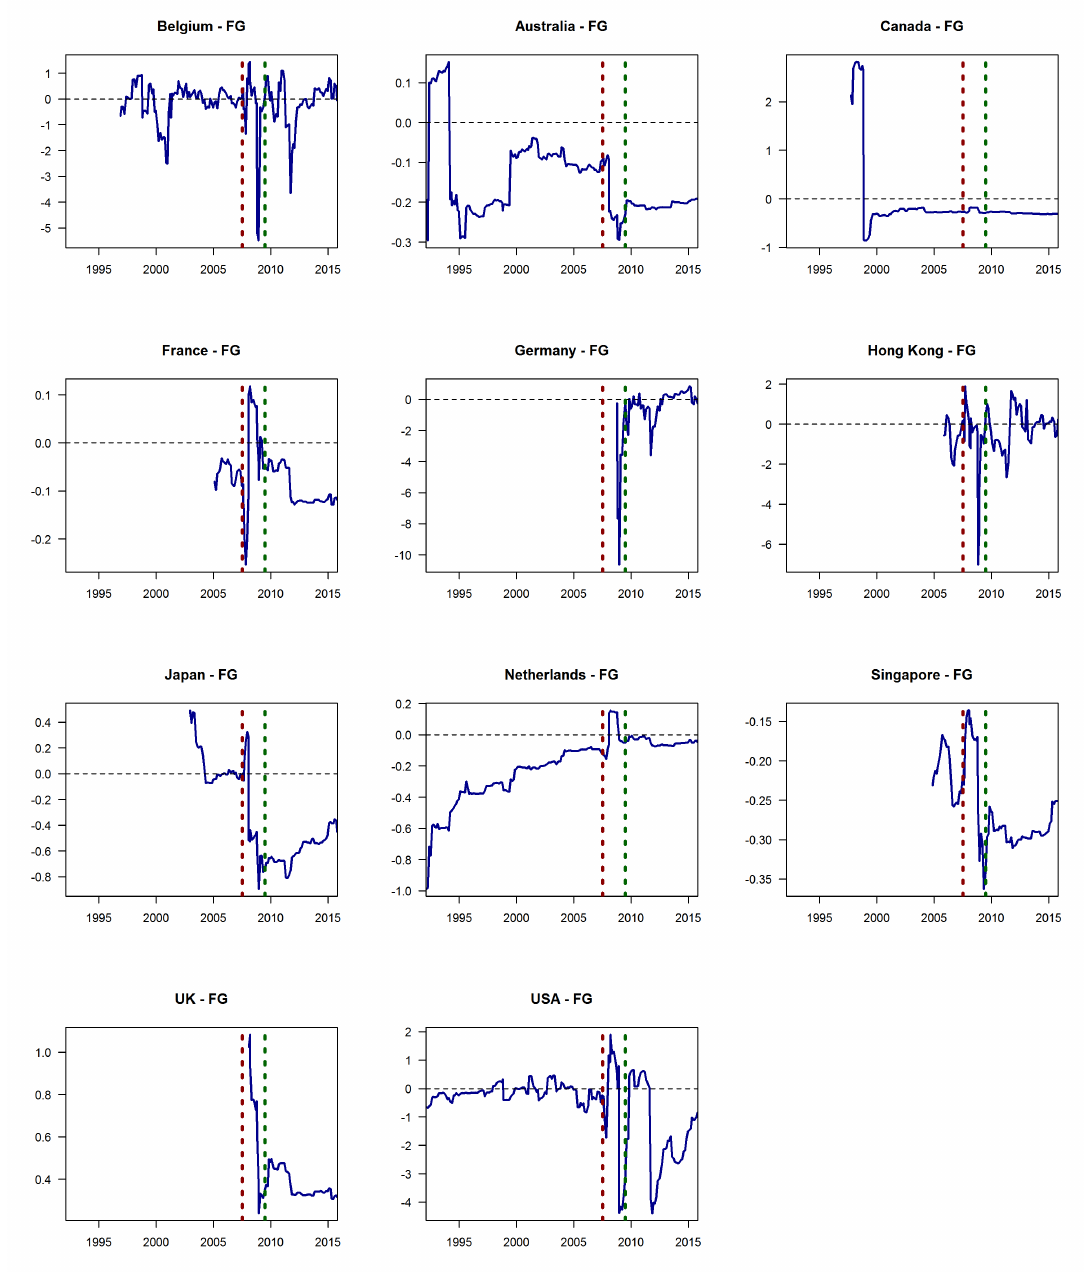
Figure 2. Time-varying impact of forward guidance shocks. The plots show the time-varying response of international REITs to forward guidance shocks. he period between the two vertical dotted lines capture the period of global financial